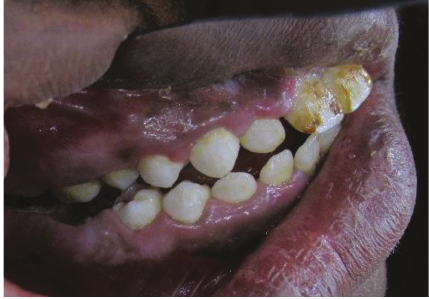
Figure 15: Case 3: small size of teeth which may be due to gingival enlargement or incomplete eruption (labial view).